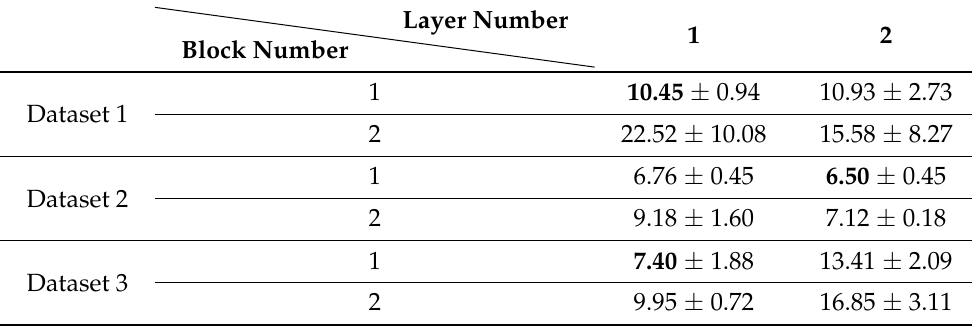
Table 4. Mean and standard deviation of RMSEs for different LSTM layers and residual block numbers on different